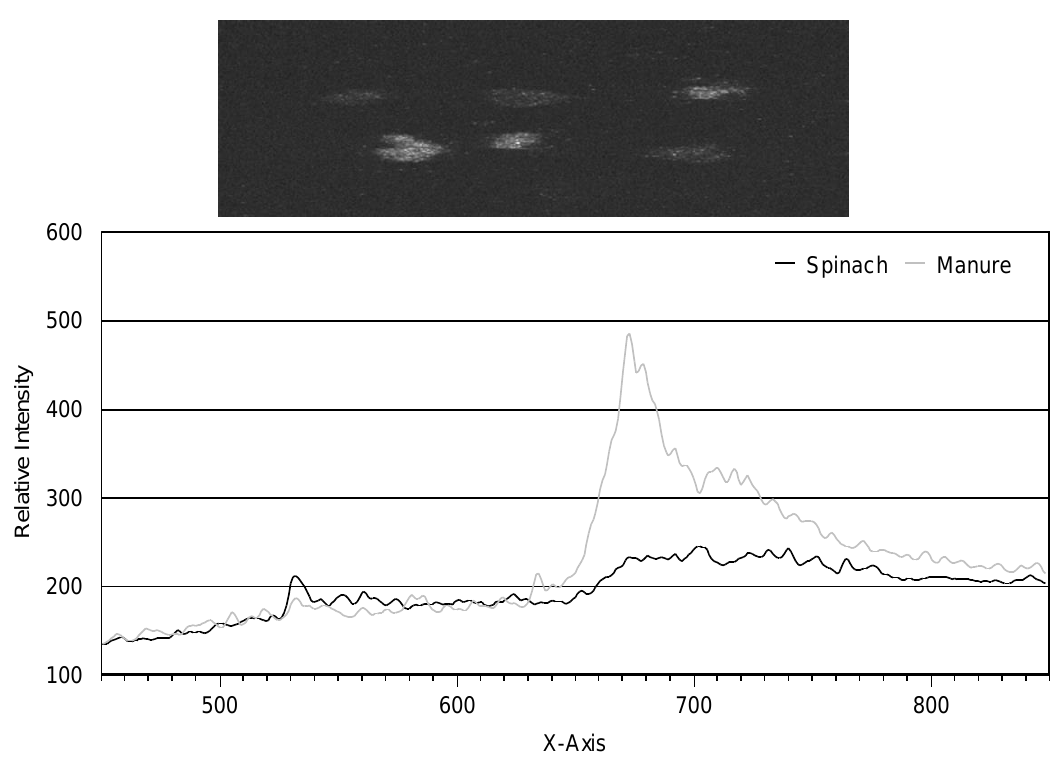
Figure 13. Fluorescence image at 673 nm using a gate delay of 20 ns and a gate width of 10 ns. The graph shows the representative spectra for spinach leaves and dairy manure.